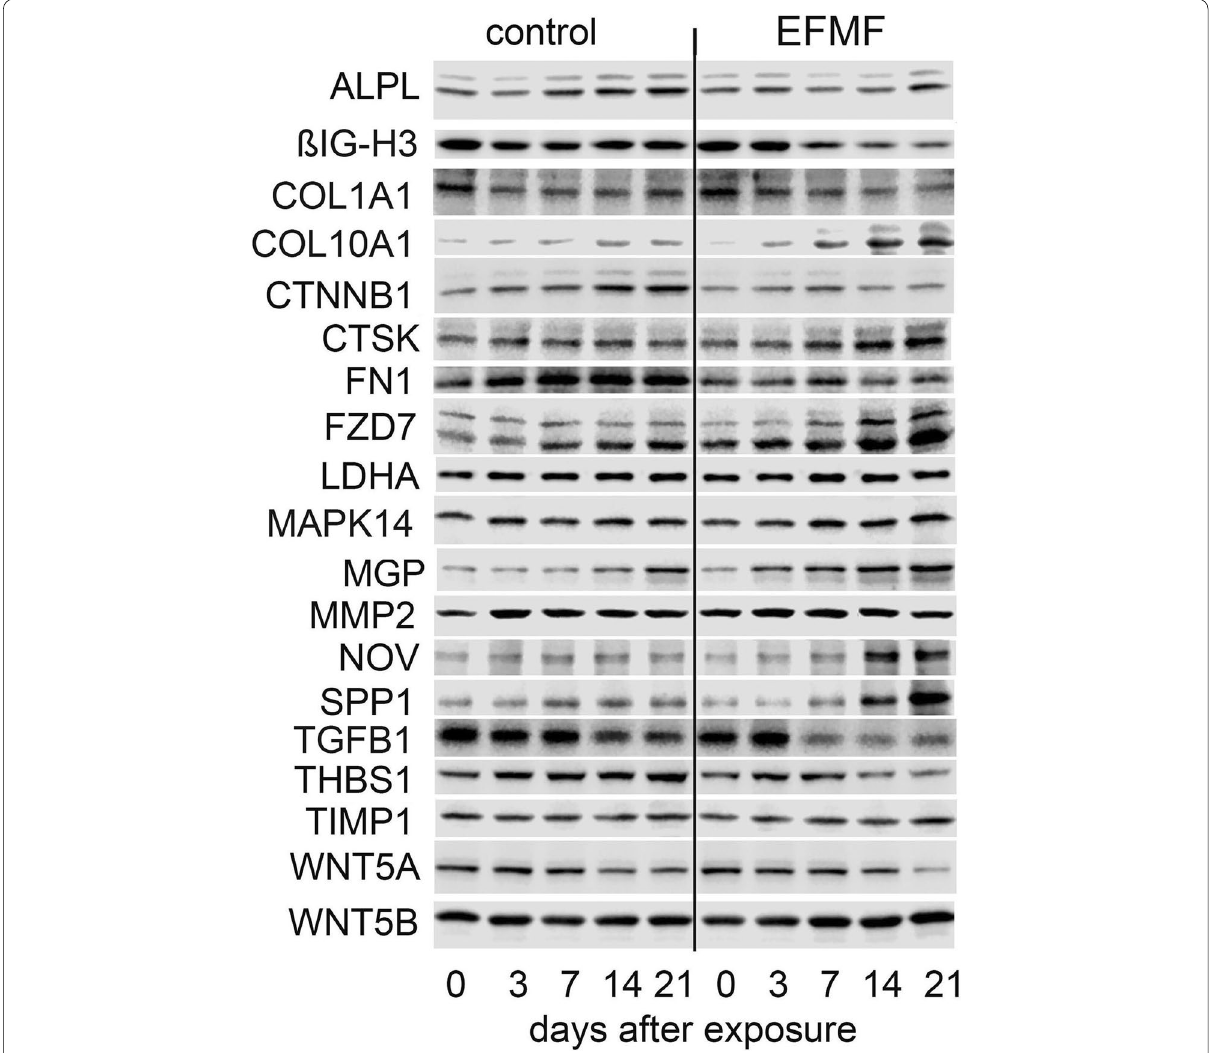
Fig. 4 Time-dependent protein expression of selected proteins of hOBs in response to EFMF treatment. Relative protein expressions were corrected to that of ß-Actin in the individual blots. Densitometric quantification is presented in Table